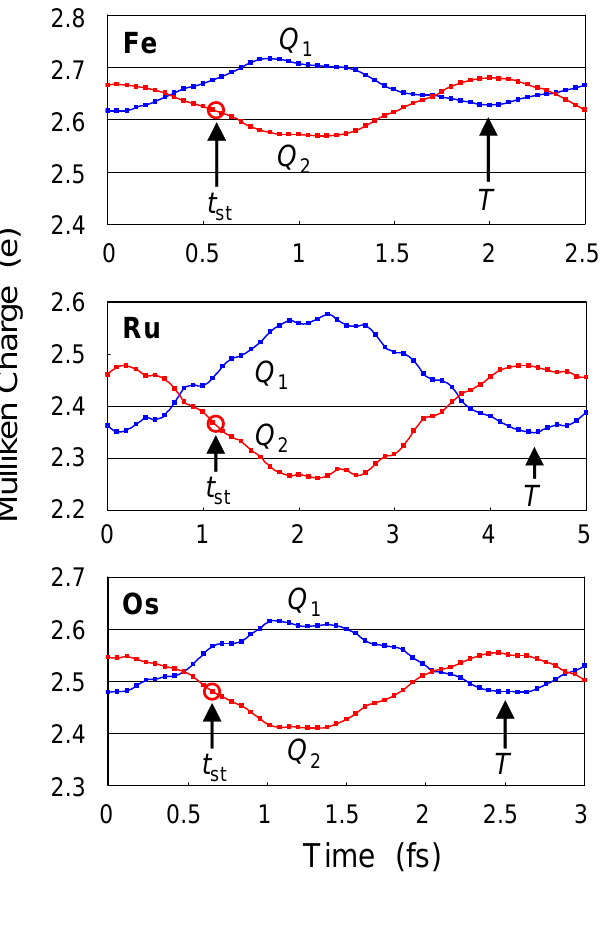
Figure 6. Dynamic behaviors of py complex upon the switch of input ( q = +0 . 5 e → q = − 0 . 5